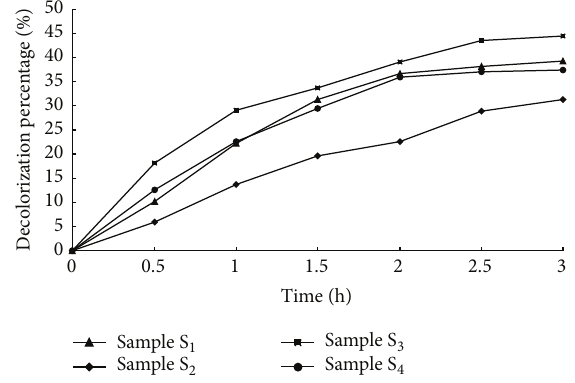
Figure 3: The adsorption property of fabricated particles.